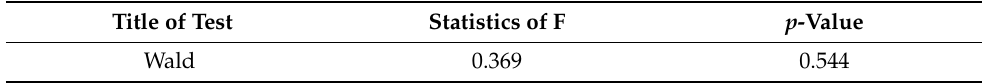
Table 13. The results of the serial correlation test of the first model. Title of Test Statistics of F p -Value Wald